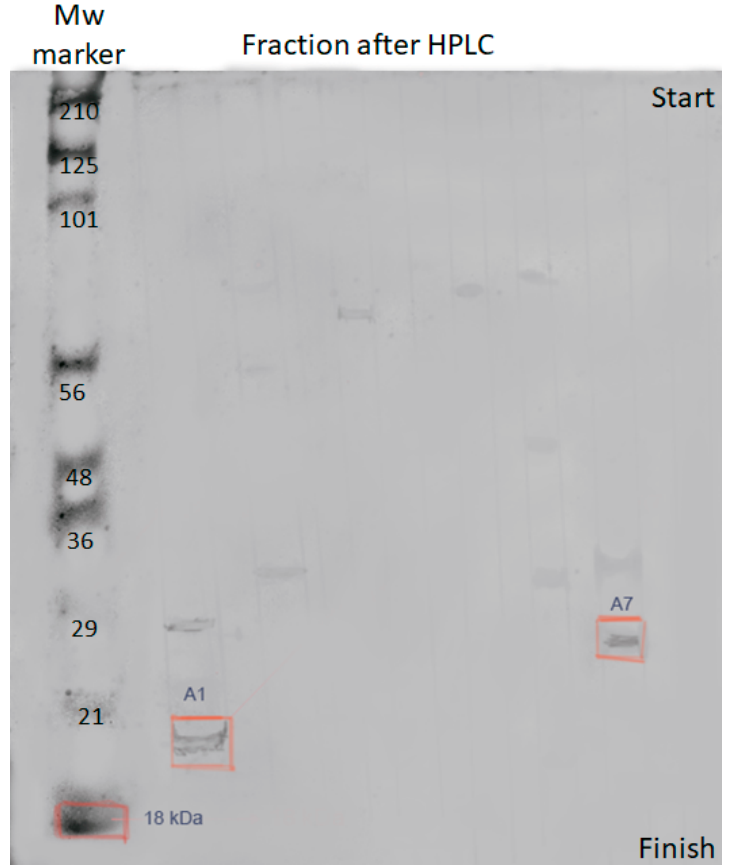
Figure 3. PAGE of fractions of metabolites A/1 and A/7. PAGE of individual fractions isolated y HPLC (peptides for fractions A1 and A7 are indicated by colored squares), weighing from 29 to 18 kDa, for which the sequence was established by the MALDI-TOF method.